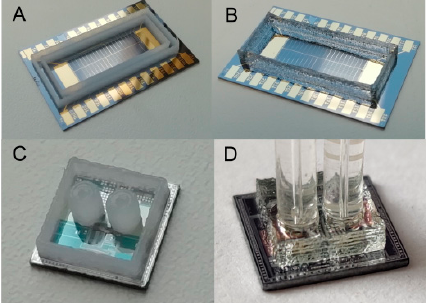
Figure 7. Formation of polymer structures on a silicon chip: ( A , C ) making of a sacrificial layer from Vaseline ink, ( B ) finished structure of the “well” type, and ( D ) a microfluidic